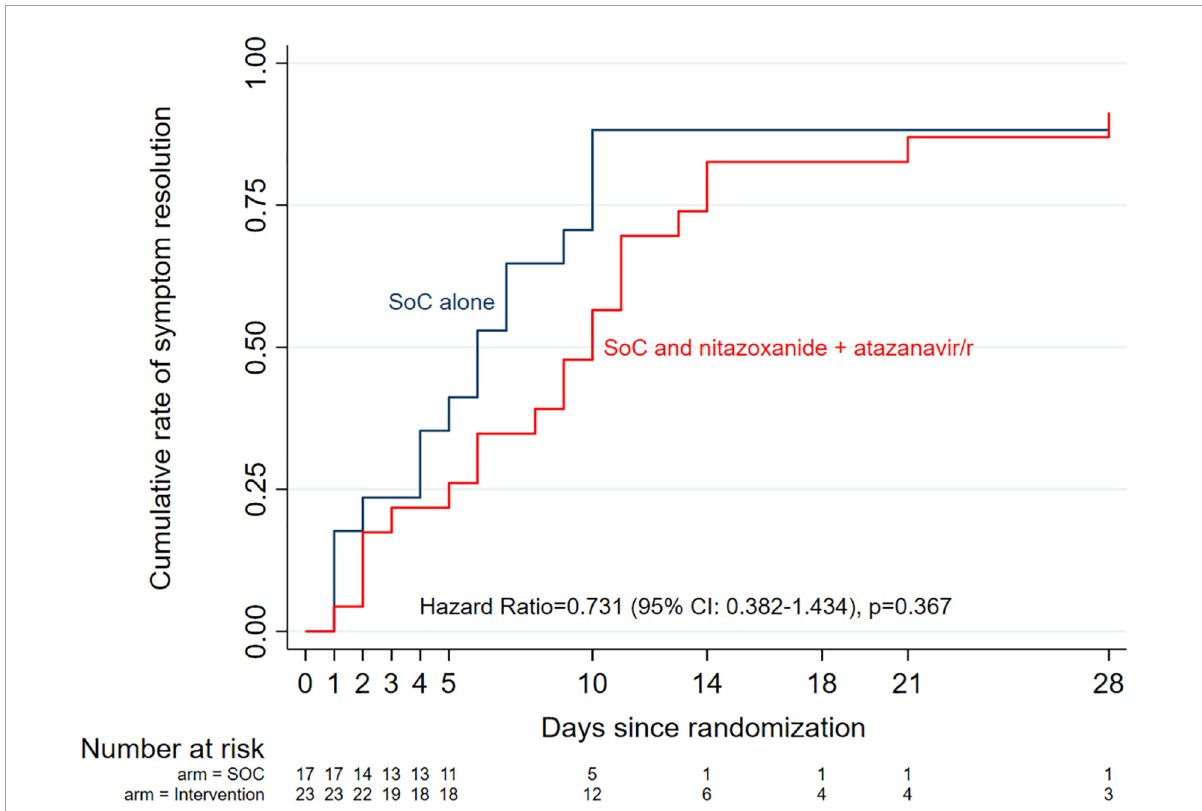
FIGURE4 Kaplan-Meier curves of median time to complete symptom resolution by study arm. Overall, there was no significant difference between the two arms, even after adjusting for potential co- founders (Cox proportional hazards model aHR = 0.535, 95% Cl: 0.251–1.140, p =